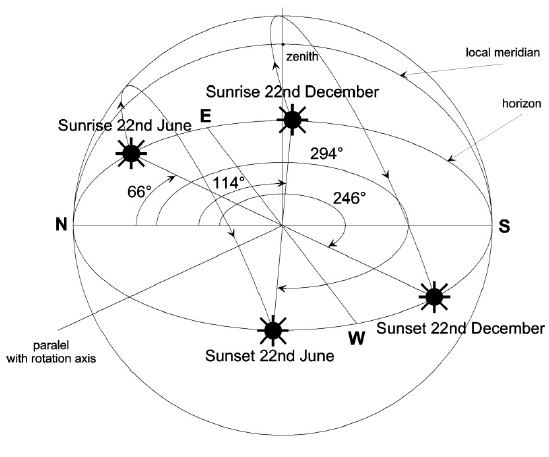
Figure 1: Astronomical azimuth of sunrise and sunset at the winter and summer solstice